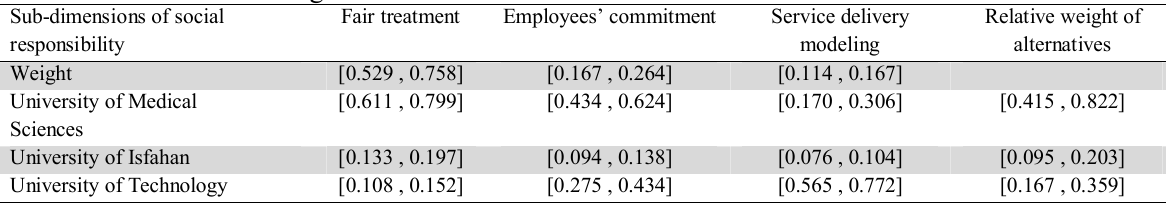
Calculation of relative weight for each alternative Sub-dimensions of social